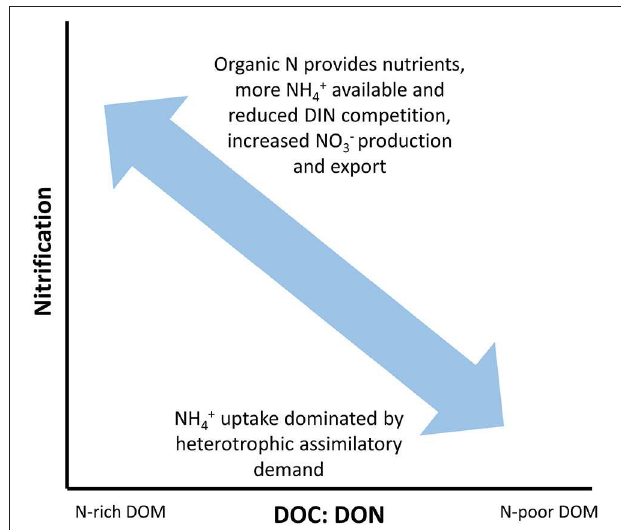
FIGURE 3 | Hypothesized relationship between dissolved organic matter (DOM) C: N ratios (DOC: DON) and nitrification. Systems with high DOC: DON ratios will have high NH + 4 uptake rates dominated by heterotrophic assimilatory demand driven by the low N content of DOM. In contrast, systems where the DOC: DON ratio is relatively low show have more NH + 4 available for nitrification since the DOM pool can provide nutrients. In turn, nitrification will lead to increased concentrations of NO − 3 leading to greater export at the network